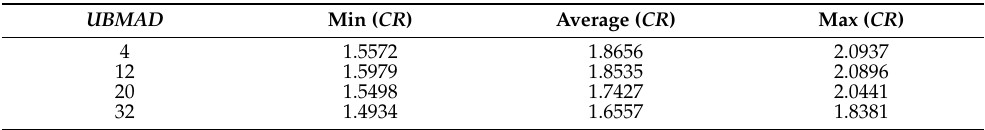
Table 3. Dependence of the minimum, maximum, and average values of CR on UBMAD for the case of DAT2 of depth 1.